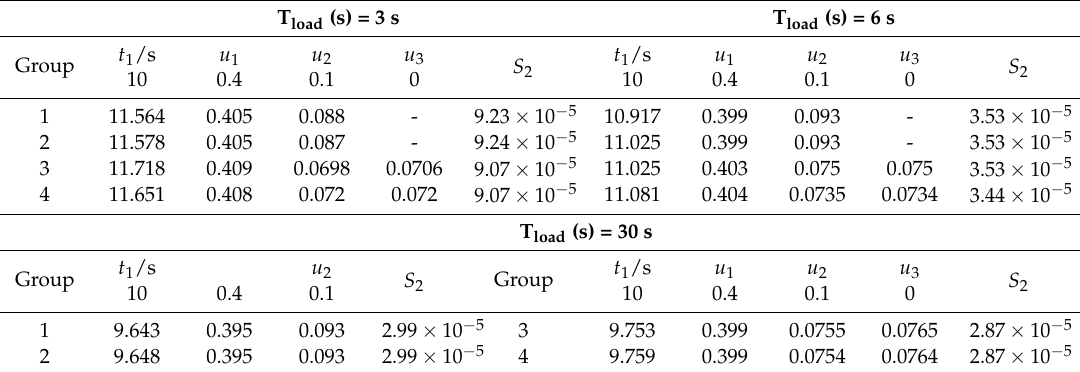
Table 3. The identified parameters by the uniaxial relaxation tests.